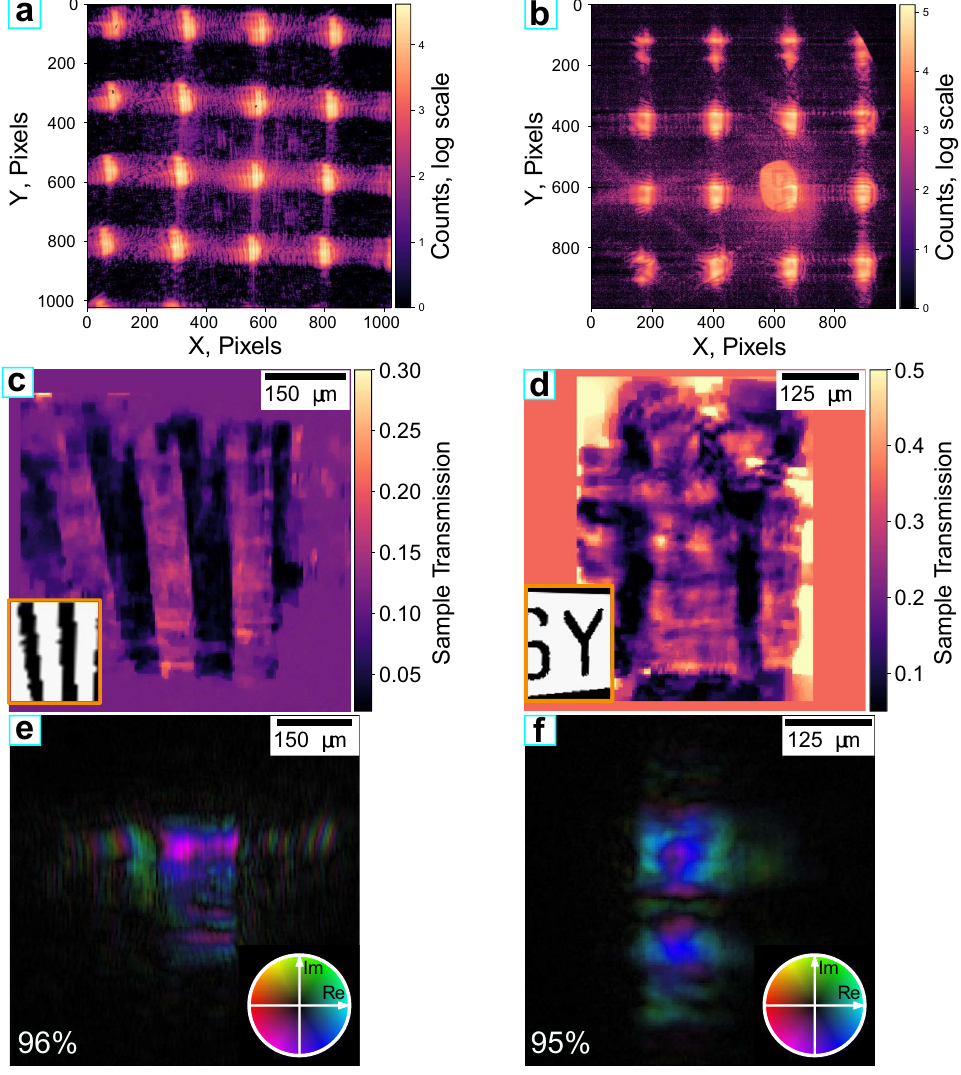
Figure 4. Raw data and results of the single-shot ptychography reconstructions. ( a , b ) Raw data used for the reconstructions of the ( c )—‘stripes’ and (d) —‘letters’ regions of the sample. ( a,b ) were measured using the Andor and the PERCIVAL detector respectively. ( c,d ) Reconstructed sample transmission for ( c )—‘stripes’ and ( d ) ‘letters’ regions of the Siemsens star sample. ( e , f ) Reconstructed complex wavefields of the main probe mode corresponding to ( b , c ), respectively. Percentages in the lower left corner represent the occupancy of the main